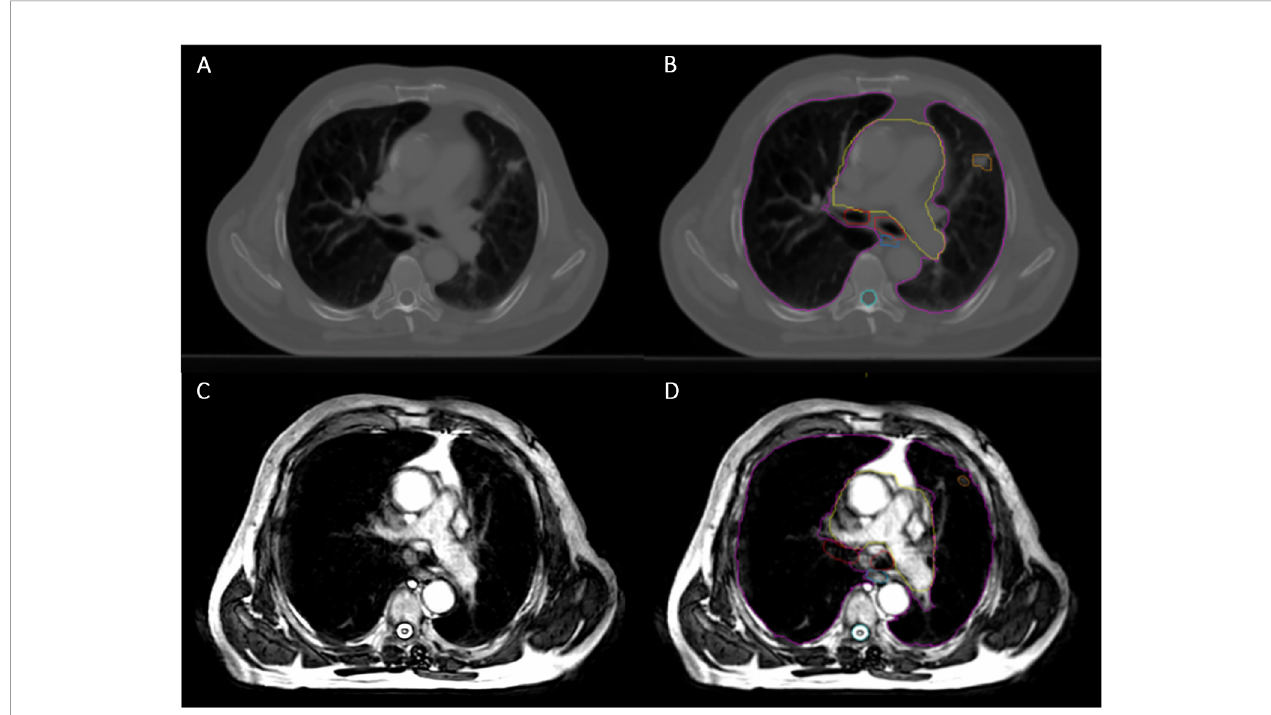
FIGURE 1 | Planning Computed Tomography (CT) image compared with MR image on the Unity. (A) Planning CT image showing small peripheral right lung tumor. (B) The same planning CT image including tumor and OAR contours (pink = lungs, yellow = heart, red = proximal bronchial tree, blue = oesophagus, cyan = spinal cord and orange = Gross Tumor Volume). (C) Unity MR image for the same patient, using 3D Vane – balanced Turbo Field Echo (bTFE) sequence. (D) The same Unity MR image including tumor and OAR contours, as described